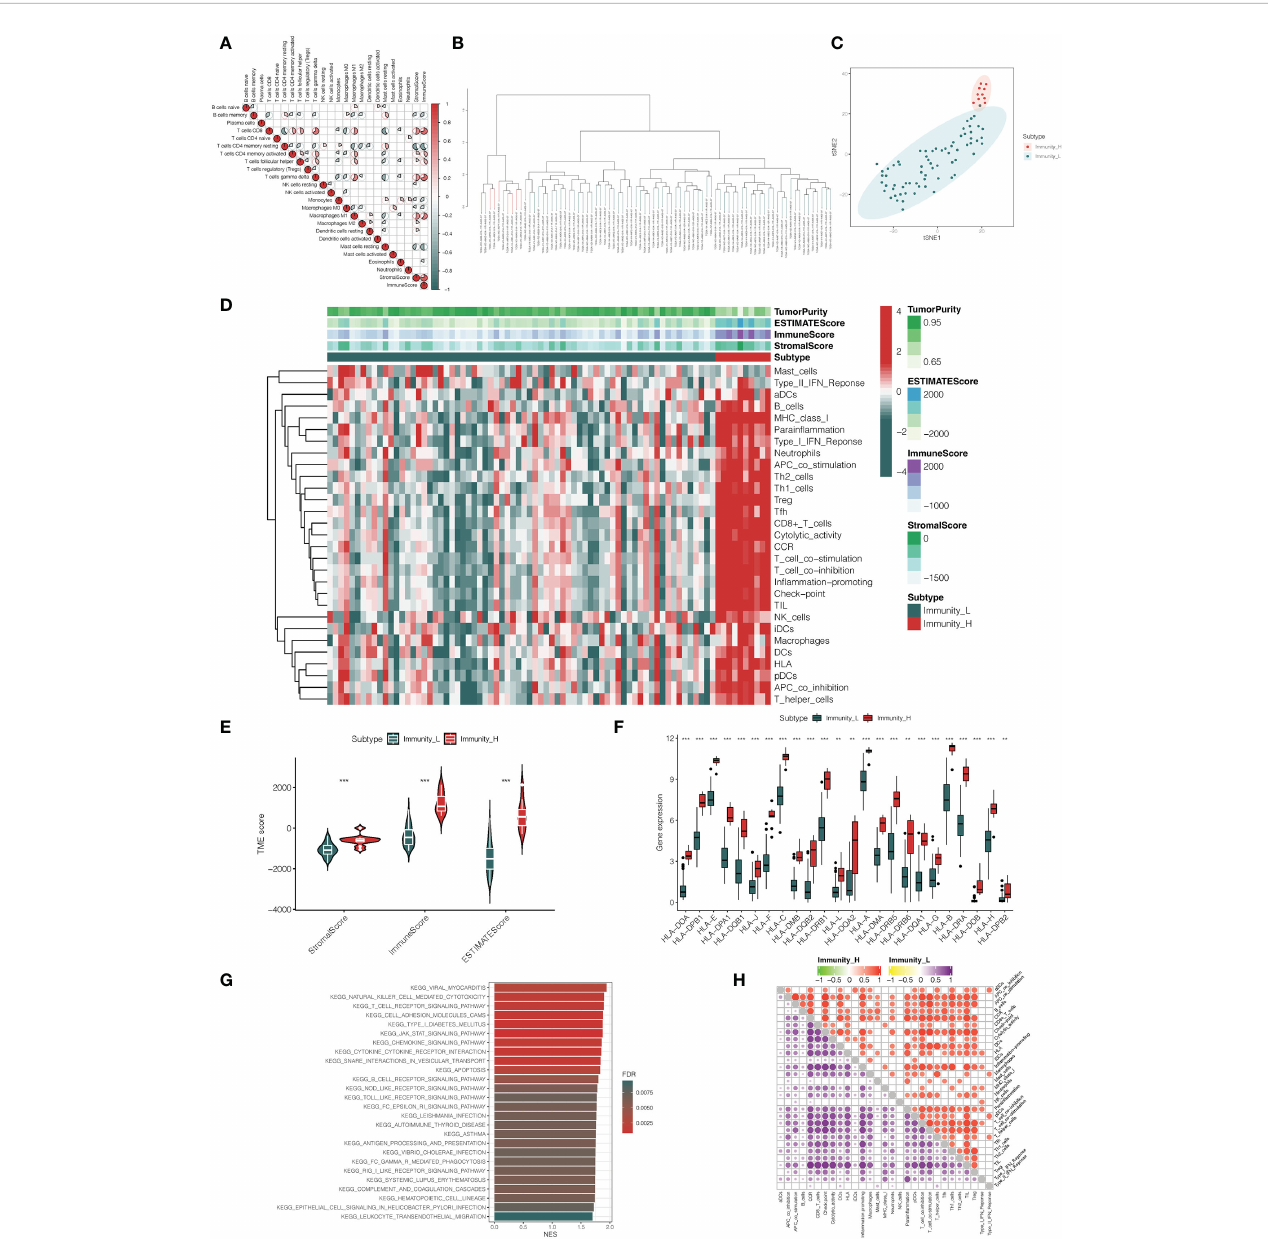
FIGURE 1 Construction and veri fi cation of uveal melanoma clustering. (A) A correlation matrix serves as a representation for all 22 invading immune cells. While certain immune cells were discovered to be positively connected and are displayed in red, others were shown to be negatively related and are shown in blue. The cut-off was established at p < 0.05. (B) The genes expression data of uveal melanoma patients were divided into two clusters by ssGSEA analysis. (C) The PCA plot of distribution status of the two uveal melanoma clusters. (D) The heatmap showed that the 29 immune-related cells and types were enriched in the high immune cell in fi ltration group (Immunity_H), and low enrichment in the low immune cell in fi ltration group (Immunity_L). Using the ESTIMATE algorithm, each patient ’ s Tumor Purity, ESTIMATE Score, Immune Score, and Stromal Score were displayed with the clustering information. (E) The violin plot showed the difference in ESTIMATE Score, Immune Score, and Stromal Score between two clusters. (F) The box plot showed that there was a statistical difference in the expression of the HLA family between the two groups. (G) The gene functional enrichment analysis of Immunity_H and Immunity_L clusters. (H) Microenvironmental immune cell pro fi ling of Immunity_L and Immunity_H. ** p < 0.01, ***p <